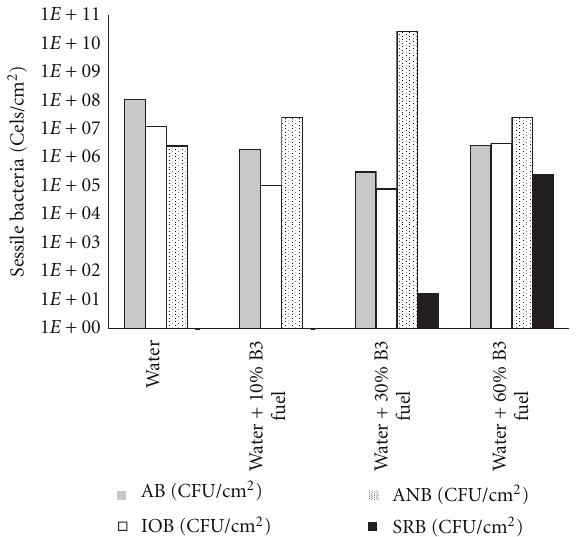
Figure 2: Sessile microorganisms in AISI-1020 carbon steel after 15 days under a flow of 1 L/s of water and mixtures of water + B3 fuel at concentrations of 10%, 30%, and 60%.